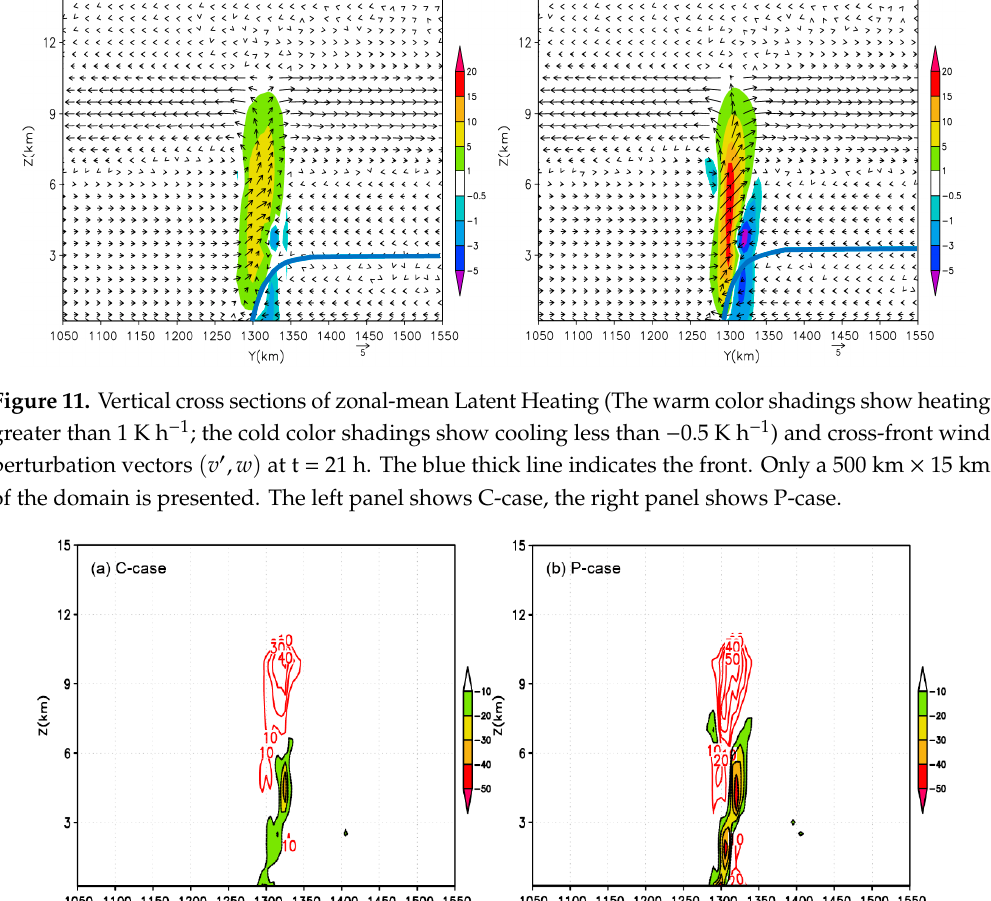
Figure 13. During the initial stage of precipitation (t = 15 h), the differences of the frontal boundaries and the cross-front circulation between the two cases are negligible. However, there is a slight difference in the intensity of the front (Figure 13a,b). Comparing the tendency of the virtual potential temperature gradients in the two cases, the difference is obvious at high levels around 6 km. While there is less of difference at low levels below 2 km. This is in agreement with the latent heat distribution.